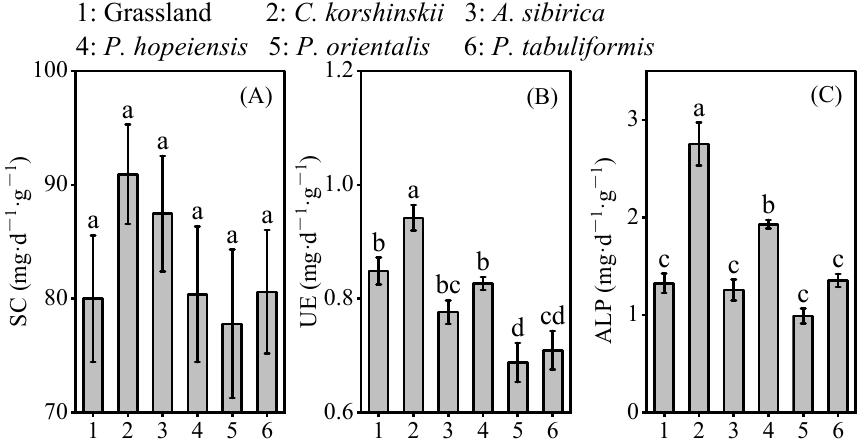
Figure 3. ( A – C ) indicate different small panels, which are 3 soil enzyme activities. Comparison of